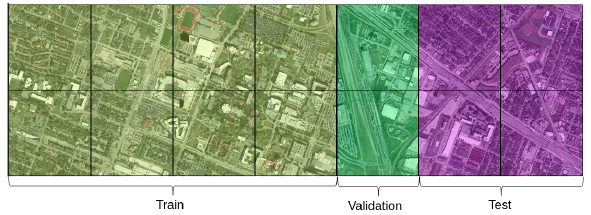
Figure 3. Train (8 tiles) / Validation (2 tiles) / Test (4 tiles) split on DFC